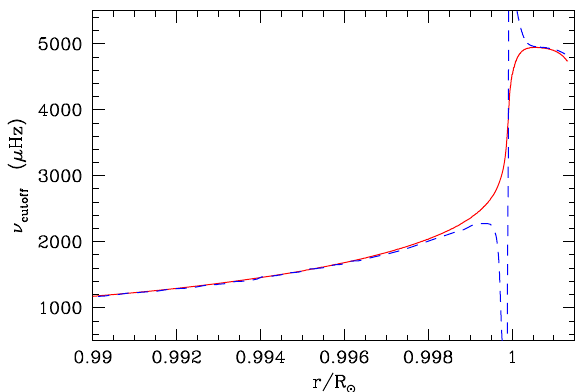
Fig. 3 The acoustic cut-off frequency of a solar model calculated as per Eq. (80) is shown as the blue dashed line . The red curve is the cut-off assuming that the model has an isothermal atmosphere. Note that the lower frequency modes would be reflected deeper inside the Sun than higher frequency modes